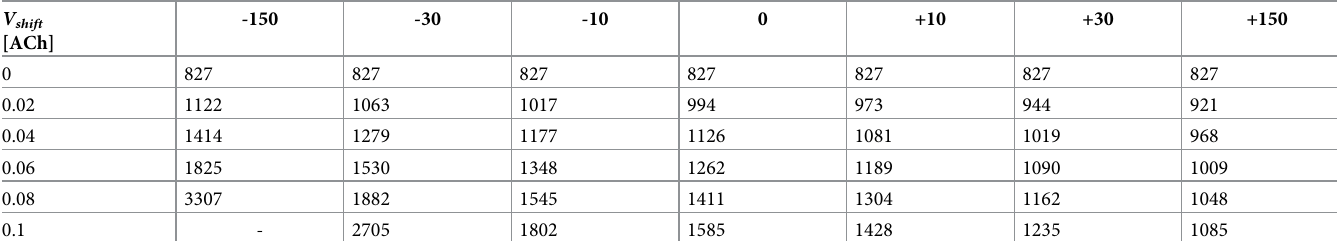
Table 1. Basic cycle lengths (ms) at different concentrations of ACh ( μ M) and shifts in the voltage affinity of M2R (mV). V shift [ACh]